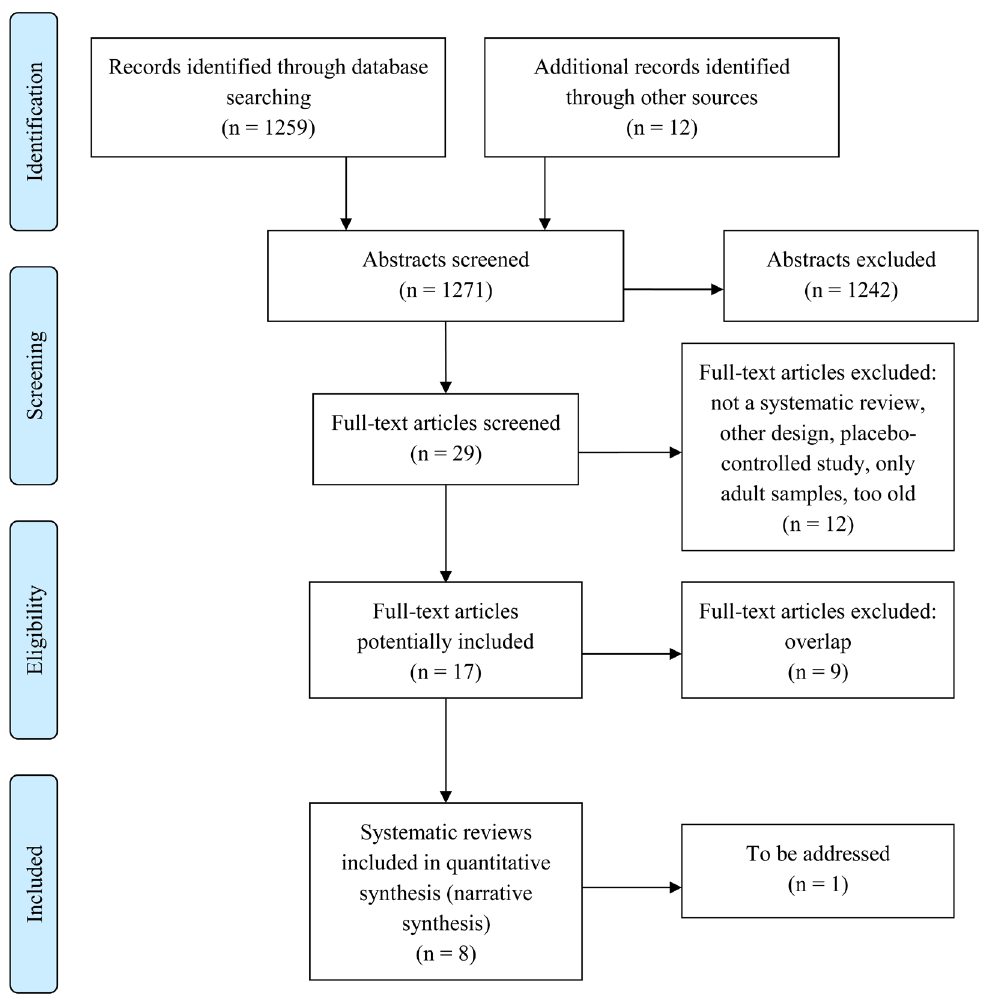
Figure 1. PRISMA flow chart of the study search